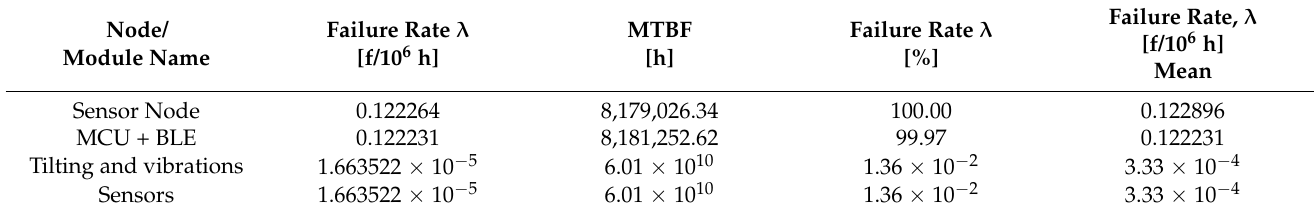
Table 4. Reliability analysis of the sensor node structure considering all the blocks working on demand mode with the device in METERING mode, in 100% GB at 25 ◦